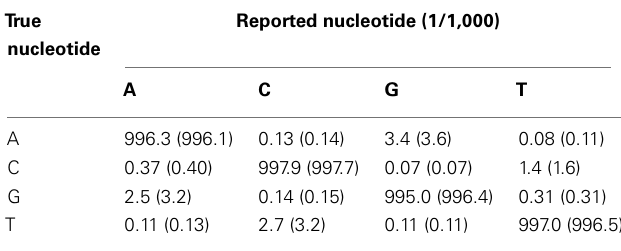
Table 2 |Average accuracy and error rate of the base-calling for the pre-PCR pooled mtDNA samples and the post-PCR pooled mtDNA